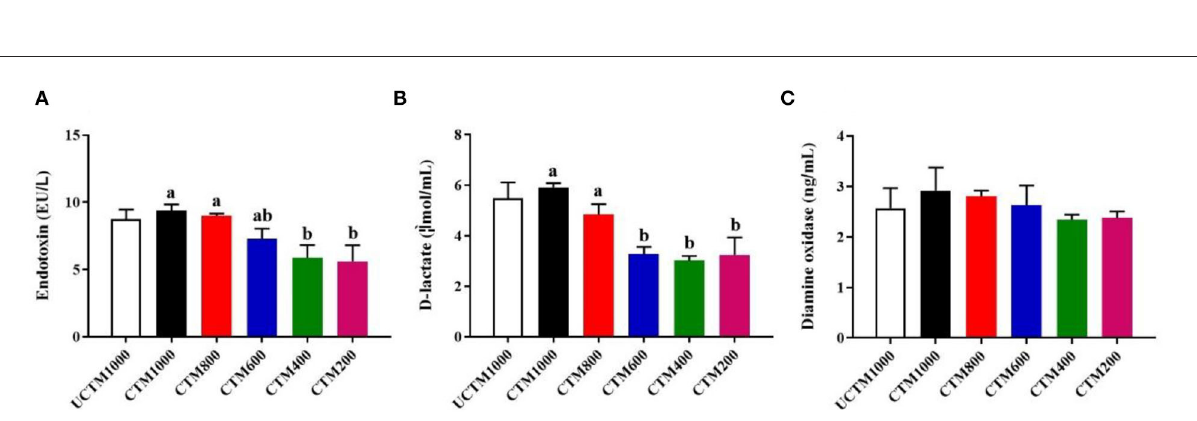
FIGURE4 Effects of dietary coated complex TMs on intestinal permeability of yellow-feathered broilers. Serum (A) endotoxin concentration, (B) D-lactate level, and (C) diamine oxidase (DAO) activity were measured. Results are mean value ± SE; n = 6 for each group. Mean values with different small letters denote significant differences among CCTM groups ( P < 0.05). UCCTM1000, supplemented with 1,000 mg/kg uncoated complex trace minerals; CCTE1000, supplemented with 1,000 mg/kg of coated complex trace minerals; CCTE800, supplemented with 800 mg/kg of coated complex trace minerals; CCTE600, supplemented with 600 mg/kg of coated complex trace minerals; CCTE400, supplemented with 400 mg/kg of coated complex trace minerals; CCTE200, supplemented with 200 mg/kg of coated complex trace